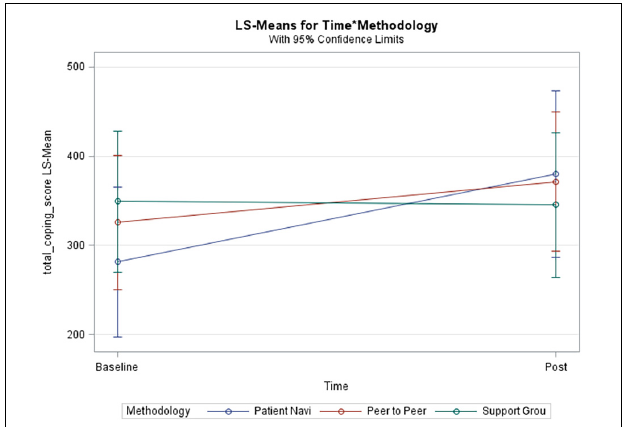
FIGURE 3 | Adjusted model of total coping score. Blue line (Patient Navi), patient navigator methodology; Red line (Peer to Peer), peer-to-peer methodology; Green line (Support Grou), support group